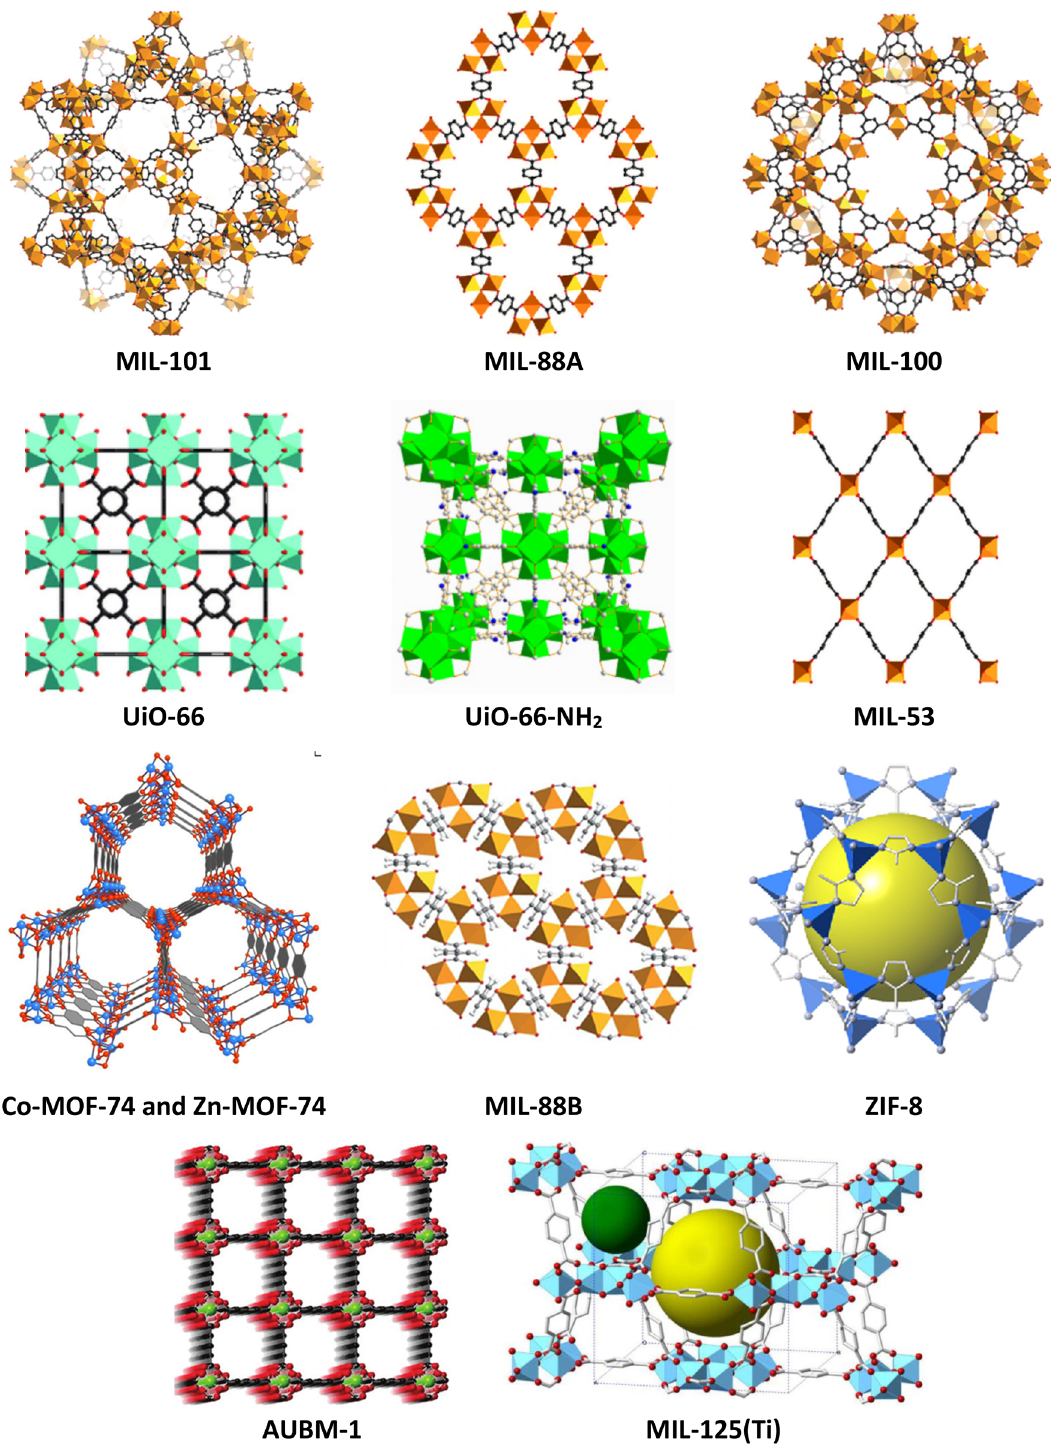
Figure 1. The framework structure of the investigated MOFs.